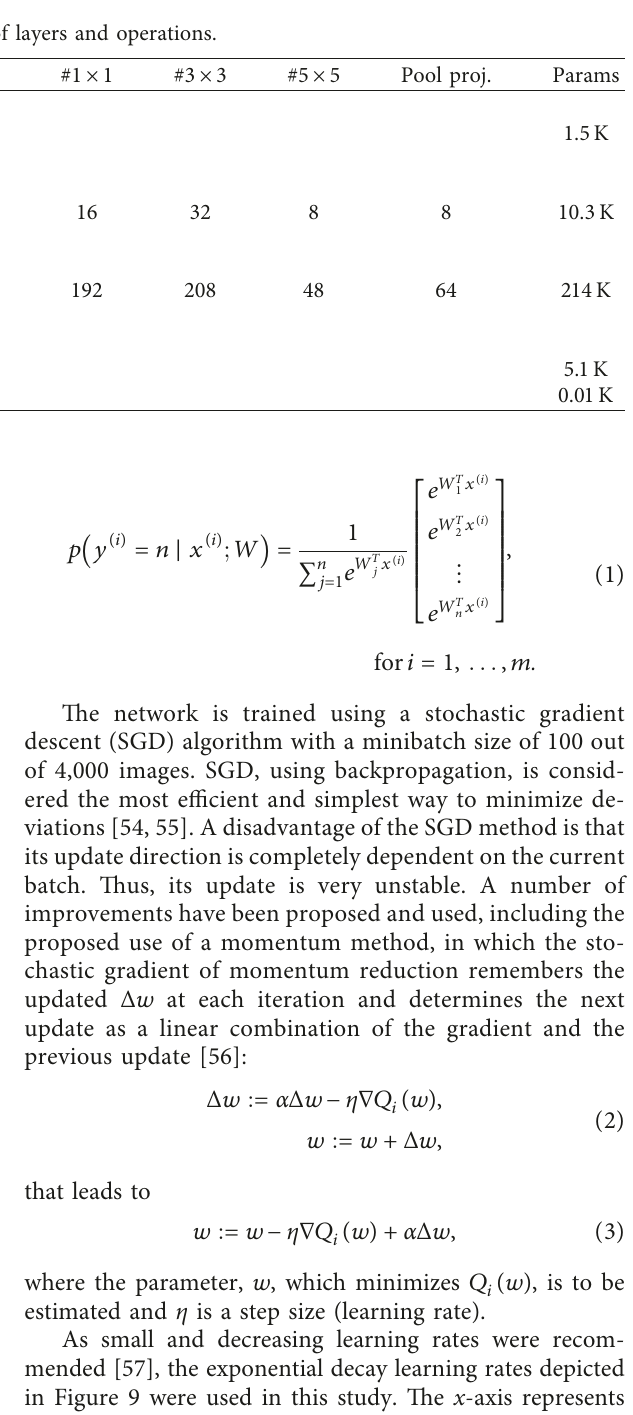
Figure 8: Nonlinear activation